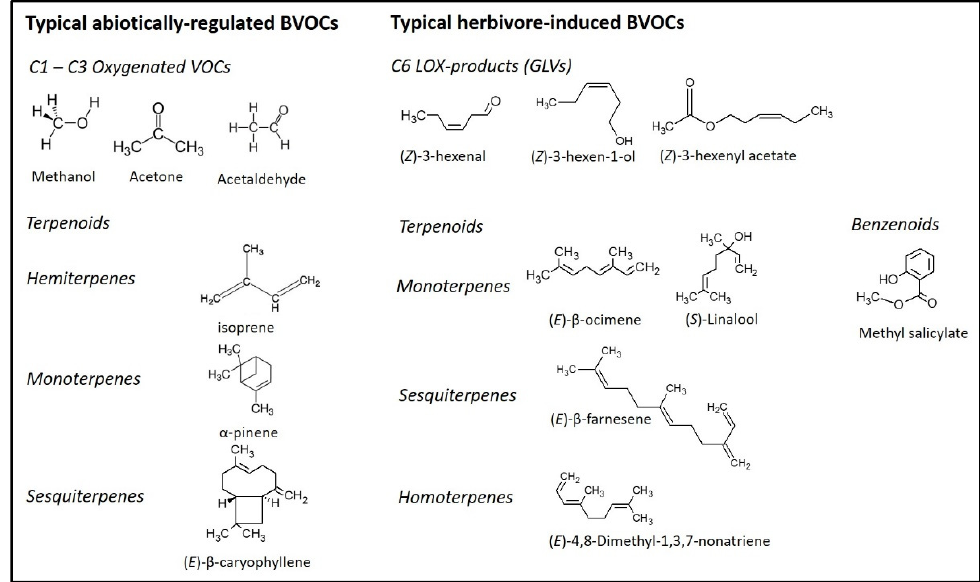
Figure 1. Examples of molecular structures of some major BVOCs emitted by boreal and subarctic forests trees. Constitutive BVOC emission rates are often regulated in response to abiotic factors such as temperature and light. Herbivore-induced BVOC emissions have strong response to herbivore feeding